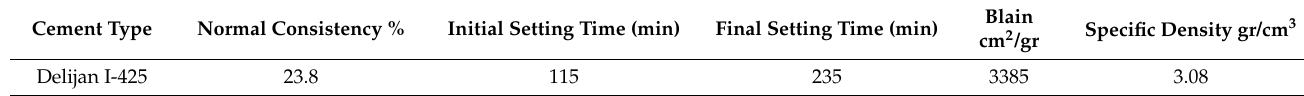
Table 3. Physical properties of cement.